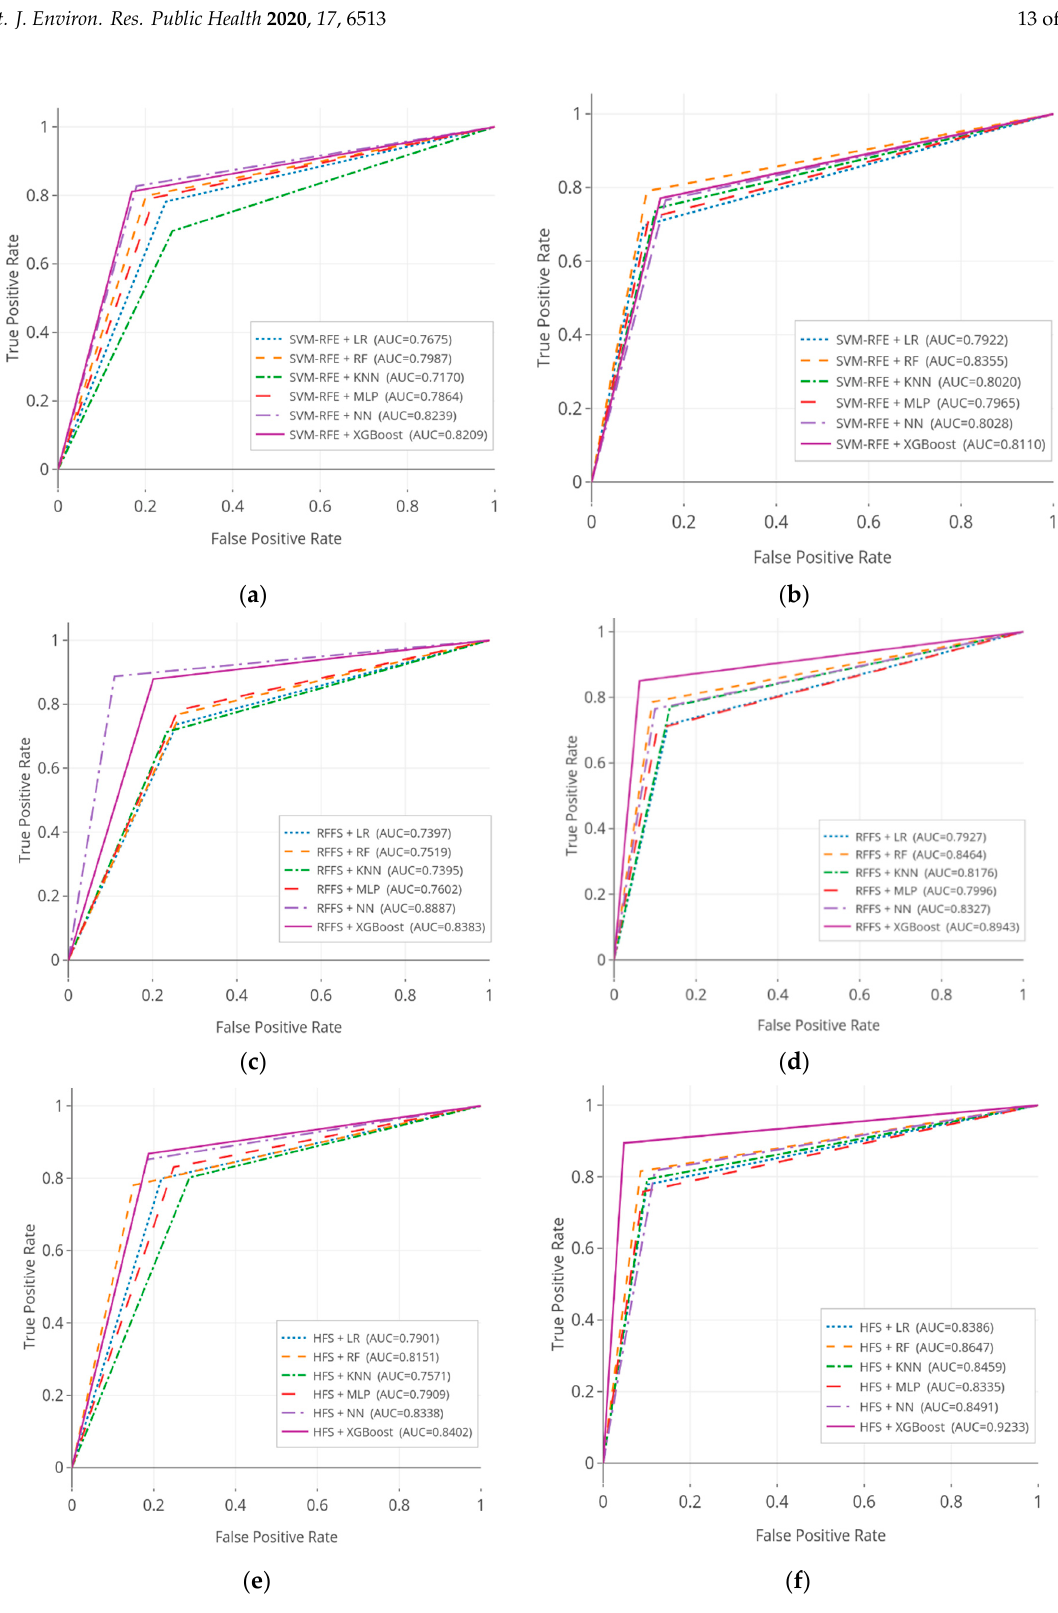
Figure 7. The comparison of receiver operating characteristic (ROC) curves for smoking-induced noncommunicable diseases (SiNCDs) prediction in the KNHANES and NHANES datasets. ( a ) ROC of SVM-RFE based models in KNHANES; ( b ) ROC of SVM-RFE based models in NHANES; ( c ) ROC of RFFS based models in KNHANES; ( d ) ROC of RFFS based models in NHANES; ( e ) ROC of HFS based models in KNHANES; ( f ) ROC of HFS based models in NHANES. The results of the KNHANES dataset reported in Table 4 and Figure 6 indicate the enhanced performances of not only the XGBoost classifier, but also the RFFS based NN considered as a computable model during the comparison task. 3.4. Interpretability of Predictive Model Prediction performance concerns the ability of the best predictive model to make correct decisions. Meanwhile, predictive model interpretability concerns the understanding of model decisions by humans. Interpretability methods can be categorized into three types: explain data, build an inherently interpretable model (in modeling), and allow to explain it after building the models [43]. In practice, there have been some needs for using machine learning models to ensure which factors are used to make key decisions with boosted trees [44]. Model inherent interpretability is important to get a reasoning behind the predictive models. However, model interpretability tends to be ignored in previous studies [15,16]. Our proposed XGBoost based framework incorporated with HFS provides important features in order to enhance the interpretability of SiNCDs prediction model across KNHANES and NHANES datasets as depicted in Figures 8 and 9. To ensure model interpretability, features were sorted in descending order of their importance scores in XGBoost based model construction in each dataset. For the KNHANES dataset, “monthly drinking rate”, “depression diagnosis”, “lifetime drinking experience”, and “total cholesterol“ were maintained as the most useful features, with importance scores of 0.2933, 0.2551, 0.1940, and 0.1763 to predict SiNCDs among the Korean population, as shown in Figure 8. While with the NHANES dataset analysis, it is evidently shown that “doctor ever said you were overweight”, “the number of people who smoke inside this home”, “general health condition”, and “age” were determined as the most important scores with 0.2158, 0.1754, 0.1621, and 0.1492, respectively, across the general population in the United States, as presented in Figure 9.